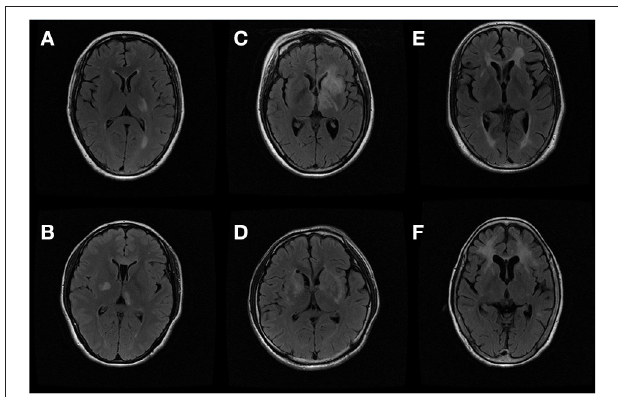
FIGURE 1 | Thalamus and basal ganglia lesions on magnetic resonance image (MRI): (A,B) thalamus lesions of multiple sclerosis (MS) and primary central nervous system angiitis (PACNS); (C,D) internal capsule lesions of MS and PACNS; (E,F) putamen lesions of MS and